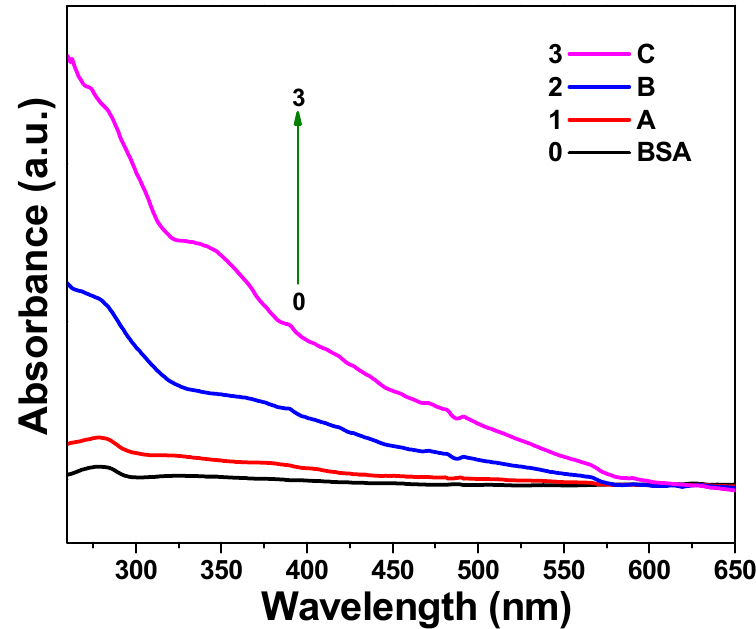
Figure 4. UV–Vis absorption spectra of aqueous bovine serum albumin (BSA) (10 − 6 M) solutions in the presence of varying IB amounts: 100 μ g ( A ), 500 μ g ( B ), and 1,000 μ g ( C ) in 10 mL of aqueous BSA solution.